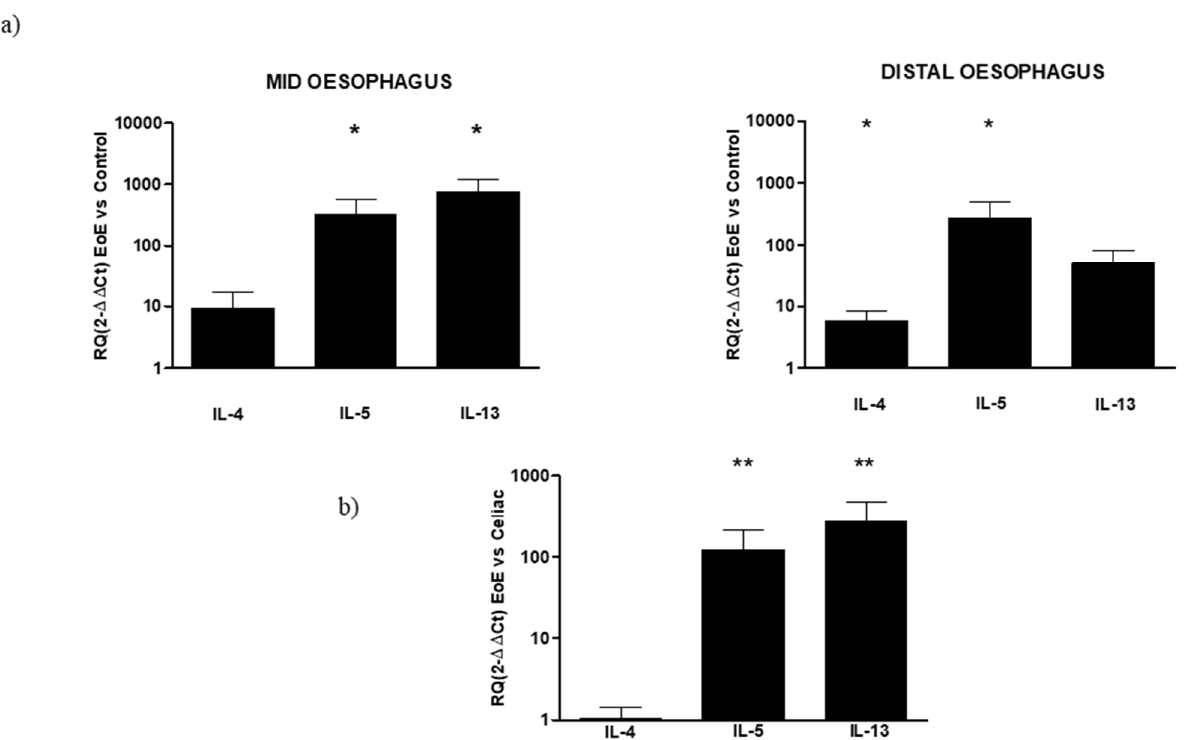
Figure 2. ( a ) Relative expression of mRNA encoding for IL-4, IL-5, and IL-13 in mucosal tissue from the mid and distal esophagus. Data are determined by qPCR (2 − ∆∆ CT vs. control). Data are expressed as the mean ± SE of four to five experiments, * p ≤ 0.05 in EoE mid or distal vs. respective control. ( b ) Relative expression of mRNA encoding for IL-4, IL-5, and IL-13 in mucosal tissue from the EoE esophagus and celiac duodenum. Data are determined by qPCR (2 −ΔΔ CT EoE vs. celiac). Data are expressed as mean ± SE of eight to 10 experiments, ** p ≤ 0.01 in EoE vs. celiac.